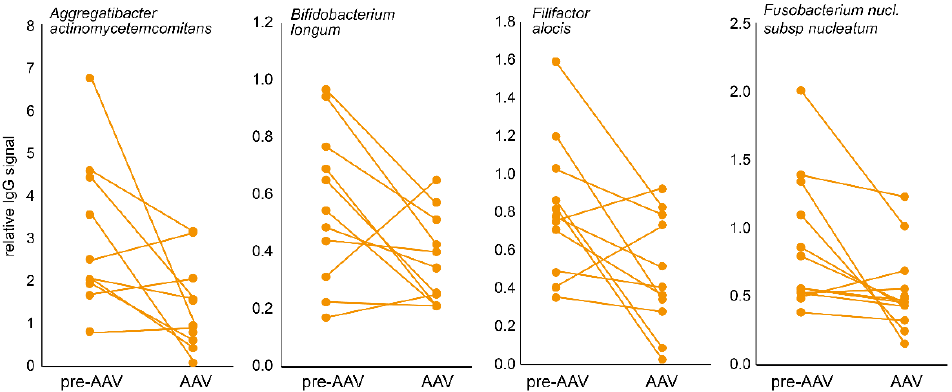
Figure 2. Typical longitudinal IgG changes in samples from pre-AAV stage individuals and when established AAV patients. Dot plots connected with a line illustrate the individual change from the pre-AAV to the established AAV stage for four bacterial species.